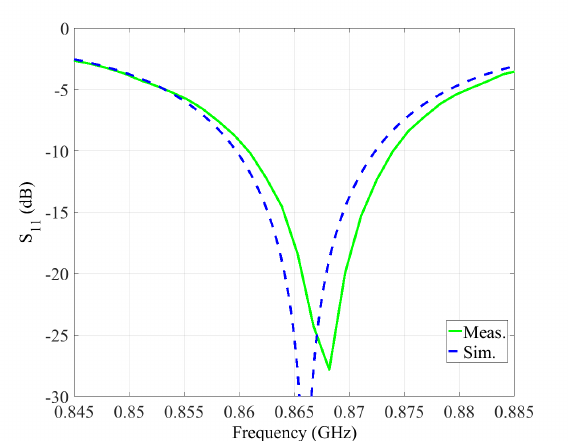
Figure 8. Simulated and measured S11 parameter of the designed antenna.